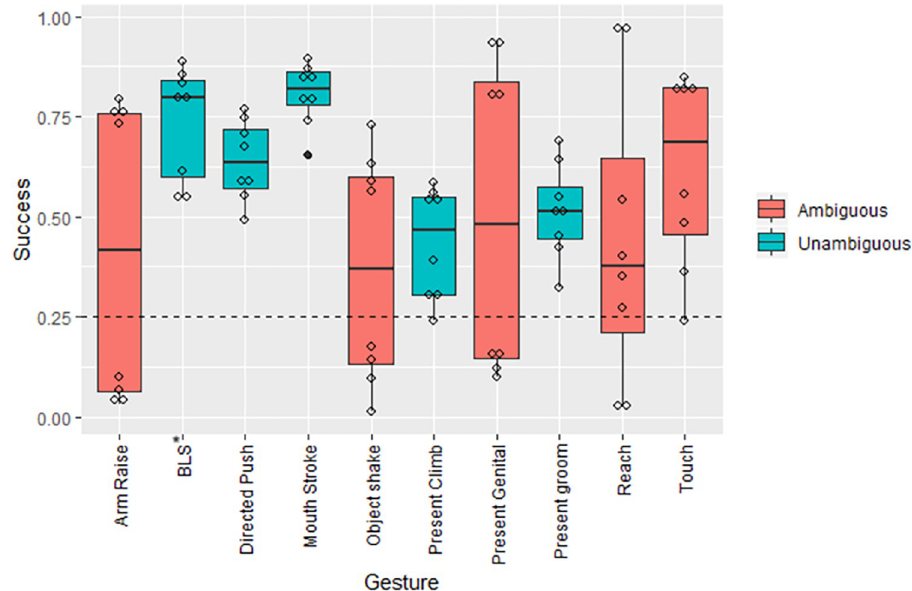
Fig 1. The distribution of correct responses for each gesture type, with the legend differentiating ambiguous and unambiguous gesture types (see https://greatapedictionary.ac.uk/gesture-videos2/ for illustrations and video examples of each gesture type; the data underlying this figure can be found at https://doi.org/10.5281/zenodo.7347608). � BLS, Big Loud Scratch.